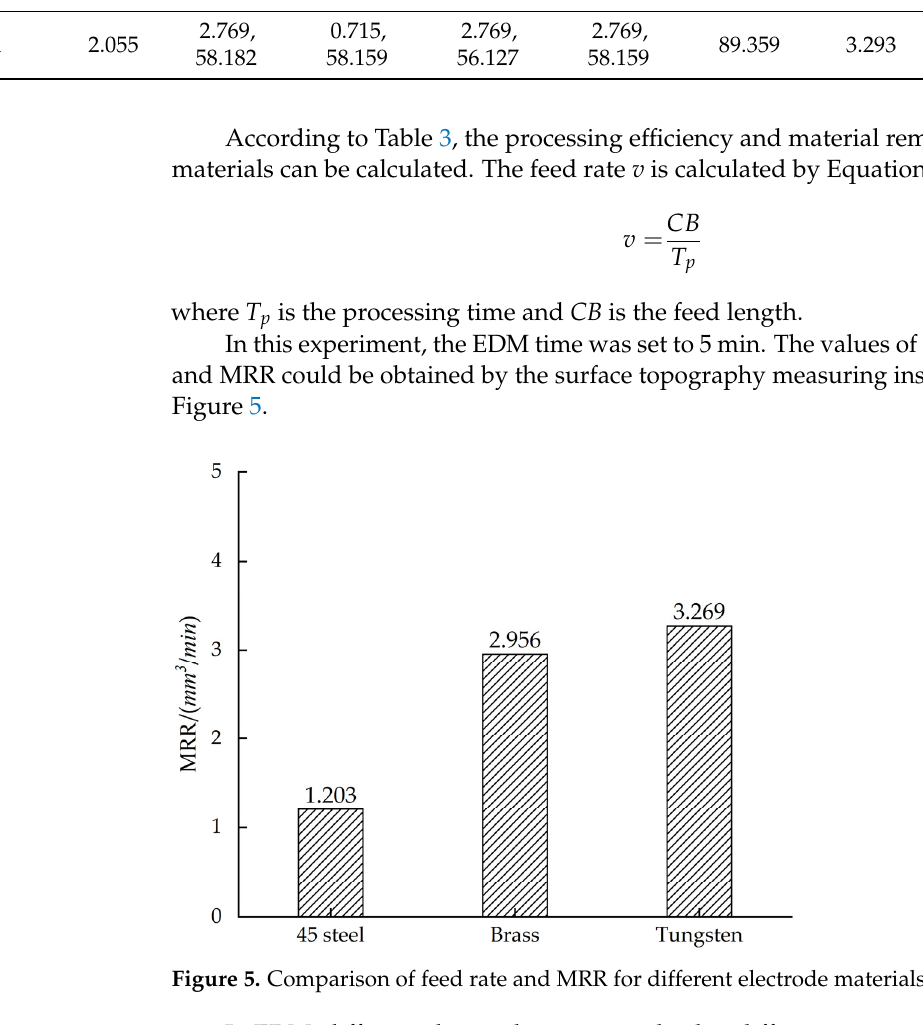
Table 3. Calculation of the data required for the determination and calculation of the erosion volume.